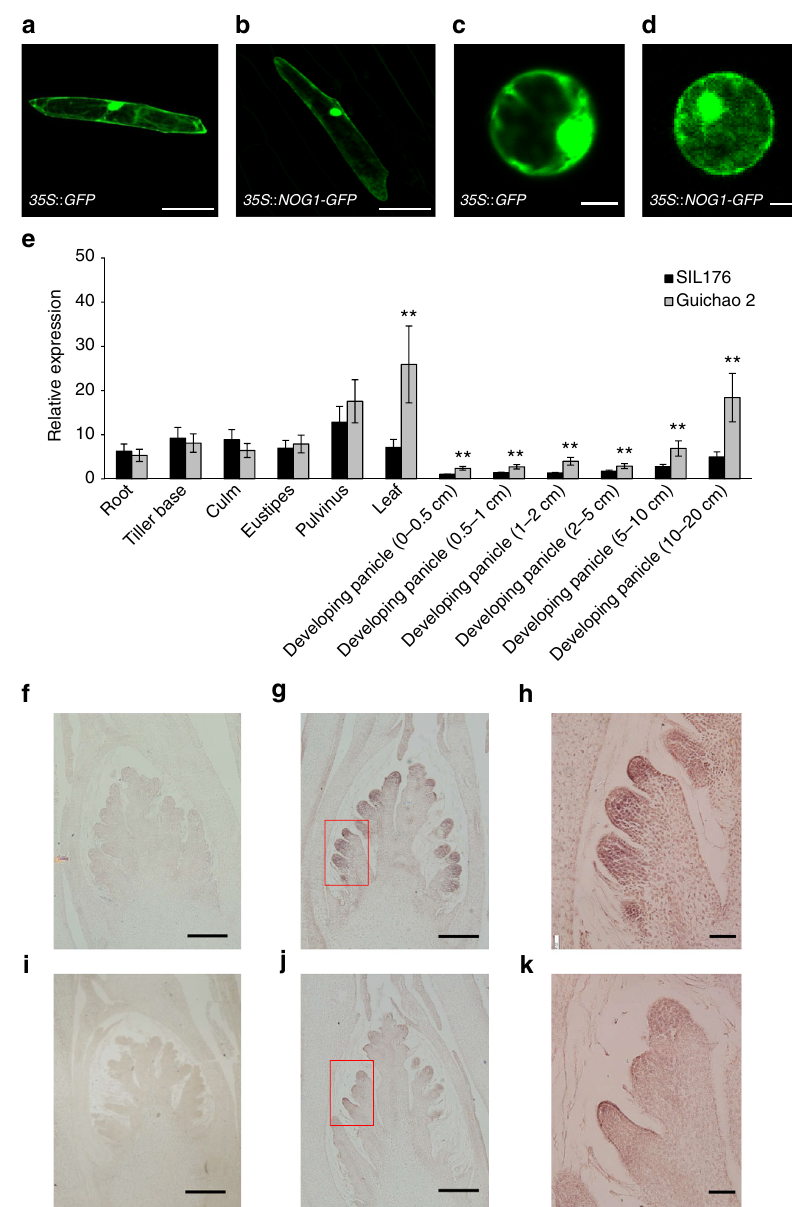
Fig. 3 Transcriptional characterization of NOG1 . a – d The subcellular localization of NOG1 protein. a , b The p35S :: GFP and p35S :: NOG1-GFP fusion gene were transiently expressed in onion inner epidermal cells. Scale bars, 100 μ m. c , d Subcellular localization of the p35S :: GFP and p35S :: NOG1-GFP fusion gene in rice protoplast cells. Scale bars, 5 μ m. The NOG1-GFP protein was localized in both the nucleus and the cytosol. e The expression pattern of NOG1 in SIL176 and Guichao 2. Expression analysis of NOG1 in root, tiller base, culm, eustipes, pulvinus, leaf, and young panicles. Data are means, with bars showing SEM, n = 3. (two-tailed Student ’ s t test; ** P < 0.01). f – h Expression patterns analysis of NOG1 revealed by messenger RNA (mRNA) in situ hybridization during panicle development in Guichao 2. f Sense probes as negative controls. Scale bars, 100 μ m; g RNA in situ hybridization of NOG1 during panicle development. Scale bars, 100 μ m; h Enlarged from g marked by a red square. Scale bars, 20 μ m. i – k Expression patterns analysis of NOG1 revealed by mRNA in situ hybridization during panicle development in SIL176. i Sense probes as negative controls. Scale bars, 100 μ m; j RNA in situ hybridization of NOG1 during panicle development. Scale bars, 100 μ m; k Enlarged from j marked by a red square. Scale bars, 20 μ Fig. 4e – h). Taken together, these results demonstrated that LOC_Os01g54860 is NOG1 that is essential for regulating the grain number per panicle and grain yield per plant in rice.